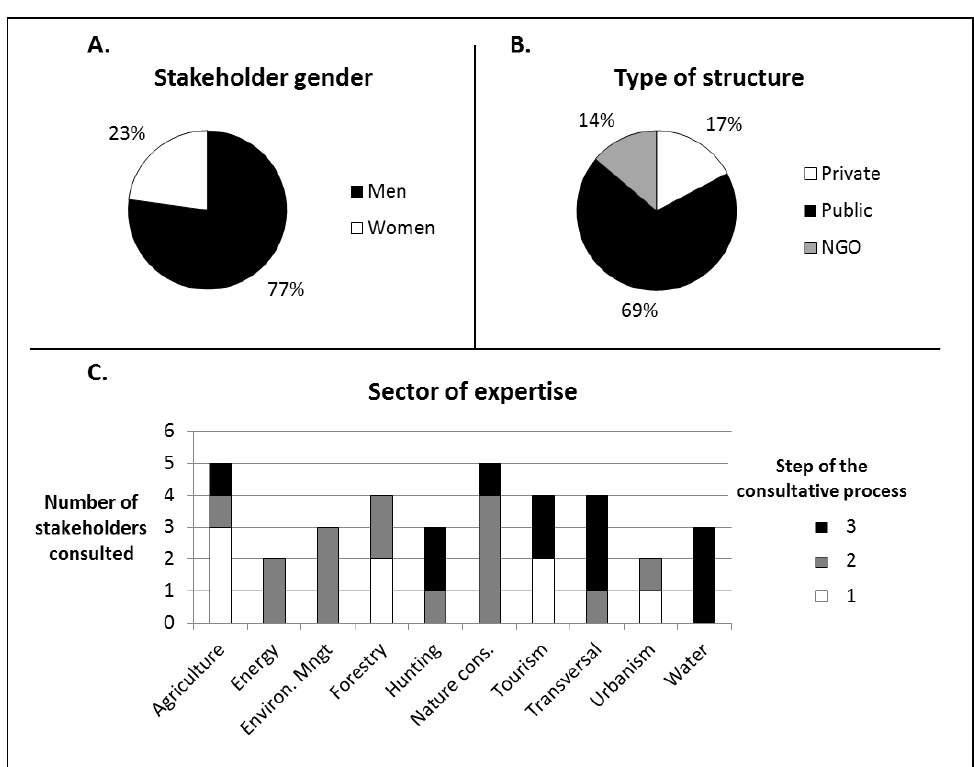
Fig.A1.1: Profiles of stakeholders consulted during the different consultation steps of the Influence Network Framework exercise: gender (A.), type of organisation (B.) and main type of expertise (C.). Envirn. Mngt: Environmental Management, Nature cons.: Nature